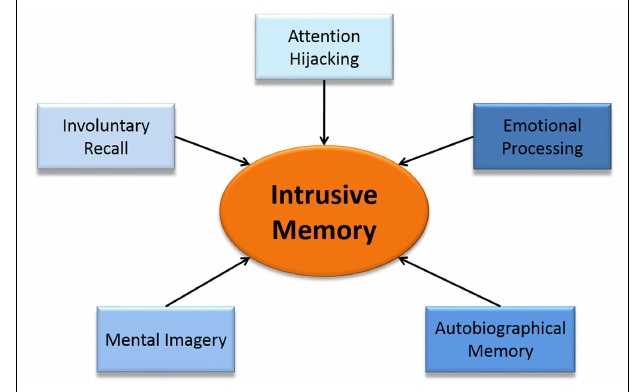
FIGURE 2 | A proposed clinical-neuroscience framework of intrusive memories breaking intrusive memories into five component parts .